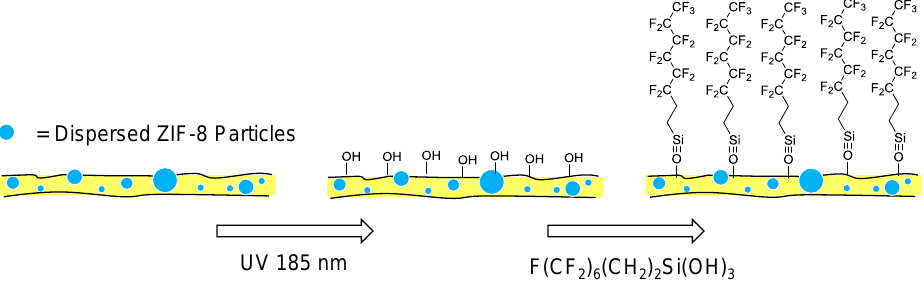
Figure 18. Surface modification of a ZIF-8-PDMS membrane with semi-fluorinated organosilanes as conducted in ref [153].